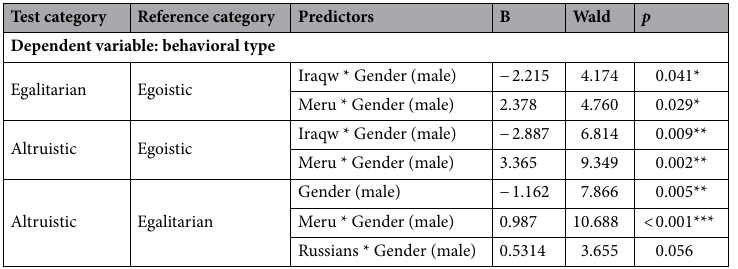
Table 5. Gender effects on children’s behavior. Multinomial logistic regression model: parameter estimates. Behavioral types: Egoistic, Egalitarian, Altruistic, and Mixed. Only significant results for three first categories